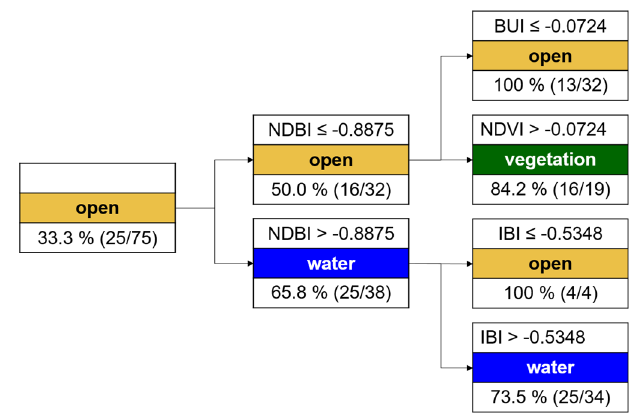
Figure A2. CART for July 2016.